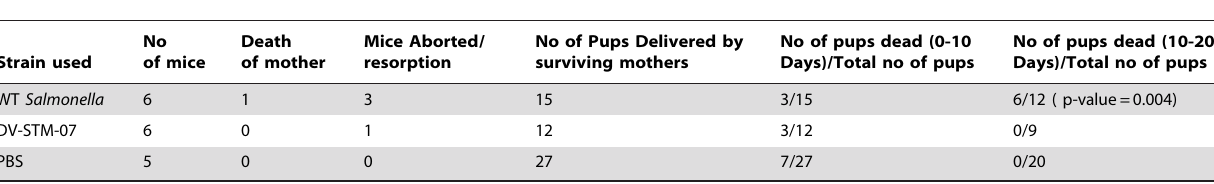
Table 1. Efficacy of DV-STM-07 vaccine in pregnant